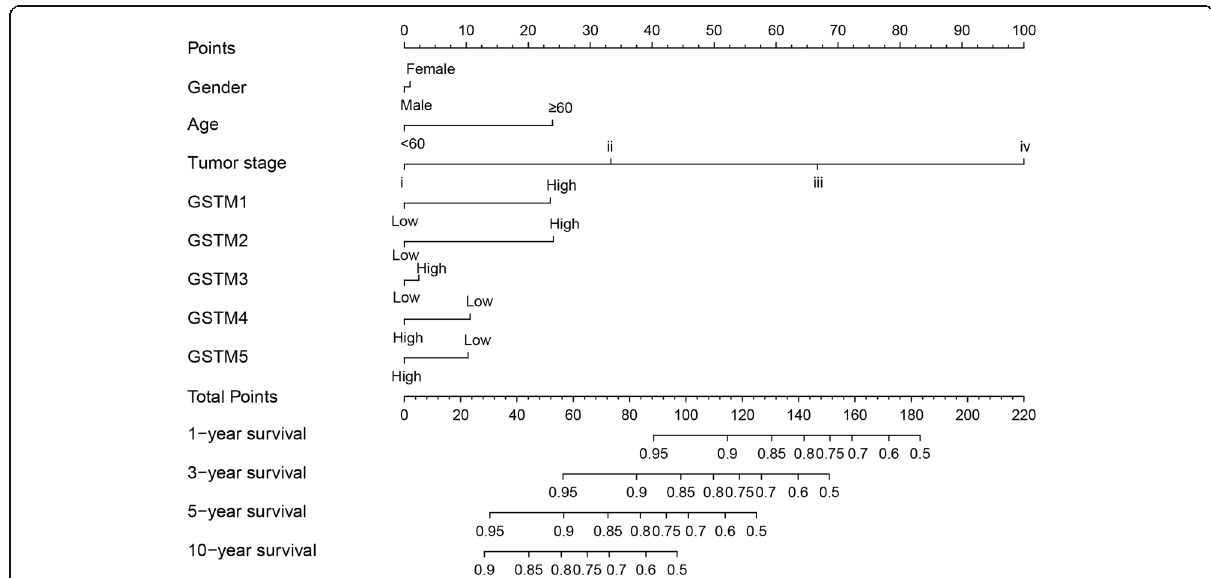
Fig. 5 Nomogram for predicting the relationship between the risk score and clinical information